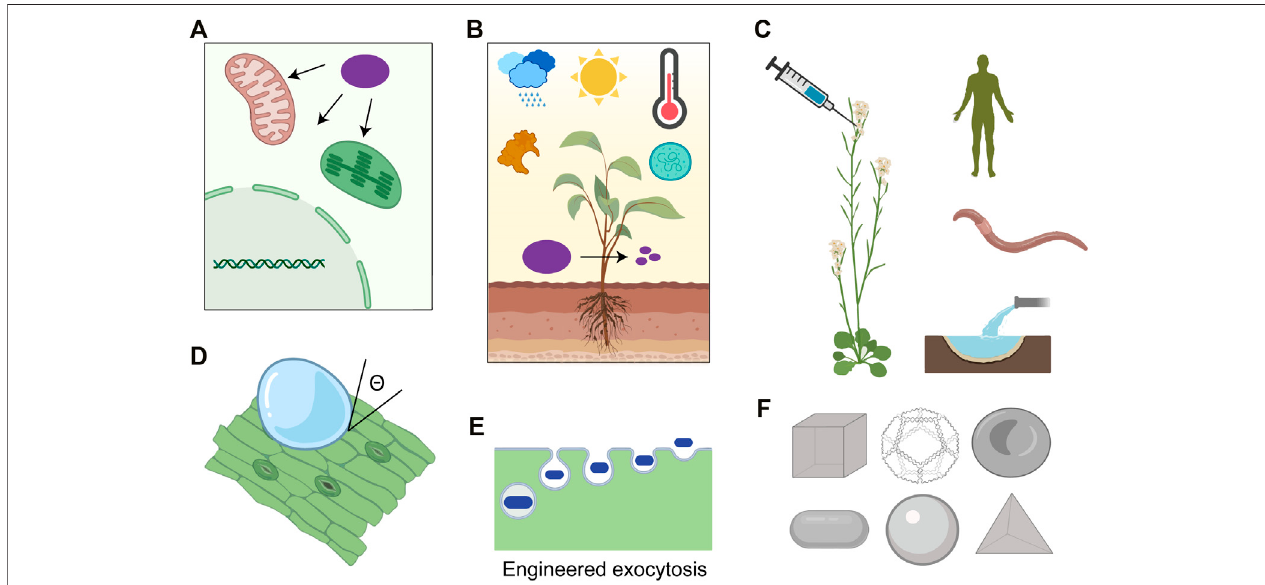
FIGURE 2 | (A) Targeting cargo, such as CRISPR reagents (purple), to organelles (green: chloroplast, red: mitochondria, and grey: nucleus) in plants allows the independent genetic engineering of these structures in their native context. (B) Nanoparticle design framework should account for the fi eld conditions the cargo (purple) wouldbeexposedto,suchassunlight,extremetemperatures,moisture,nucleases,andmicrobes. (C) Lifecycleassessmentofplantnanoparticlegeneeditingeffectson humans, soil biome, and nearby water ecosystems should be investigated. (D) Formulation optimization of the nanoparticle suspensiontomaximize wetting (represented by contact angle of suspension with leaf, ϴ ) without compromising photosynthesis. (E) Exocytosis pathways of nanoparticles from plant cells and their engineering remains unclear. (F) Nanofabrication techniques such as DNA origami can be used to study the effects of nanoparticle size, shape, and functionalization on biodistribution and editing ef fi ciencies (Created with